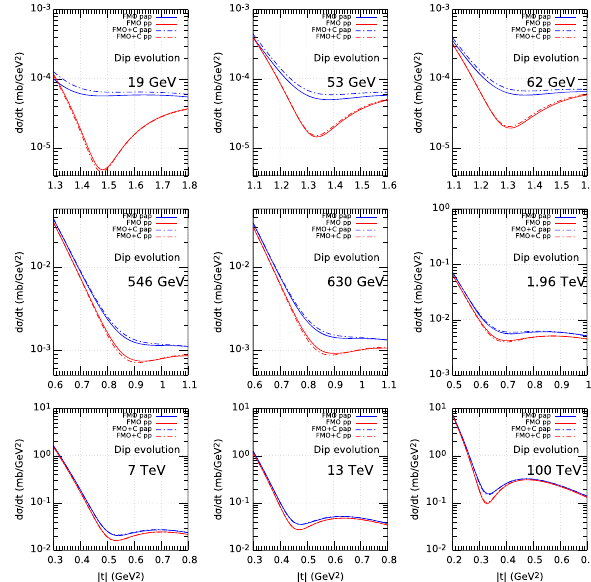
√ s = 53 GeV Fig. 10 pp and ¯ pp differential cross sections in and around the dip region